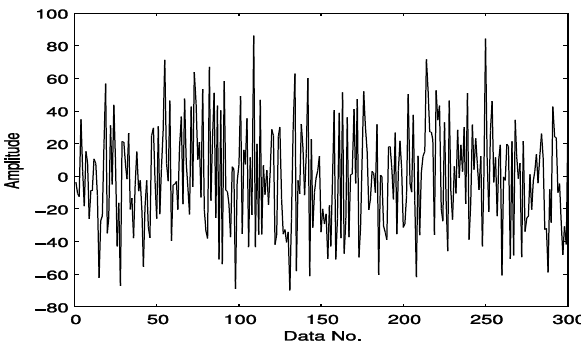
Figure 4. 10% samples of the signal as shown in Figure 3.